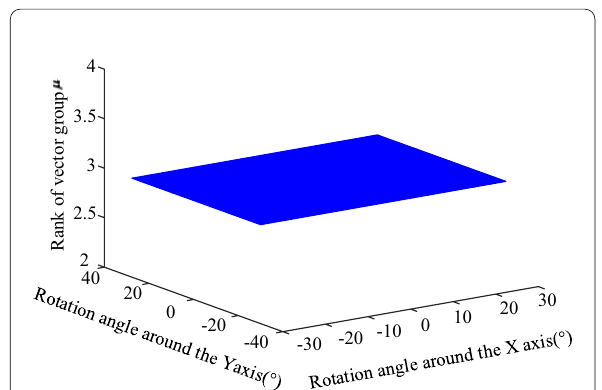
Fig. 4 Rank of each input combination vector group